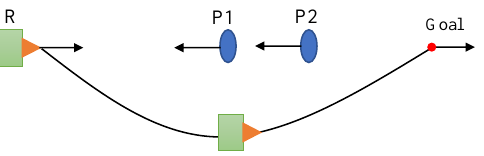
Figure 14. Proxemic aware passing strategy proposed in